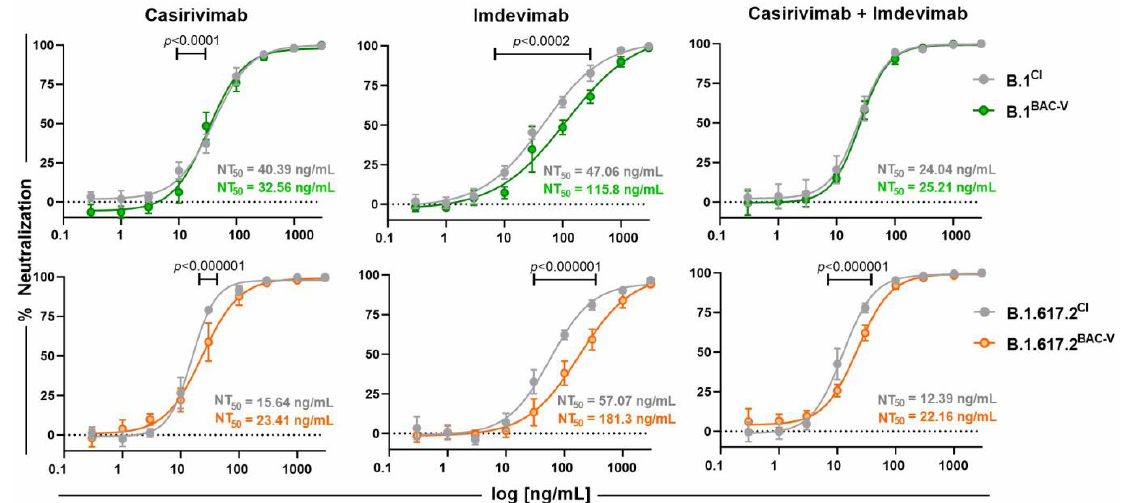
Figure 5. Efficacy of therapeutic mAbs against SARS-CoV-2 B.1 BAC-V (green), B.1.617.2 BAC-V (orange) and their corresponding clinical isolate (CI, grey). A549-AT cells were infected with indicated viruses at an MOI of 0.1 in the presence of mAbs (Casirivimab, Imdevimab or combination of both) at given concentrations. The % neutralization was determined by confluence measurement 48 hpi using Spark Cyto 400 multimode plate reader. Displayed data were normalized to controls containing only virus but no antibodies. The 50% neutralization (NT 50 ) values were calculated by performing non-linear regression on the mean of six replicates indicated by the error bars. Single data points were compared using multiple unpaired t -tests. Significant results are indicated by respective p values. The experiment was repeated three times yielding similar results.